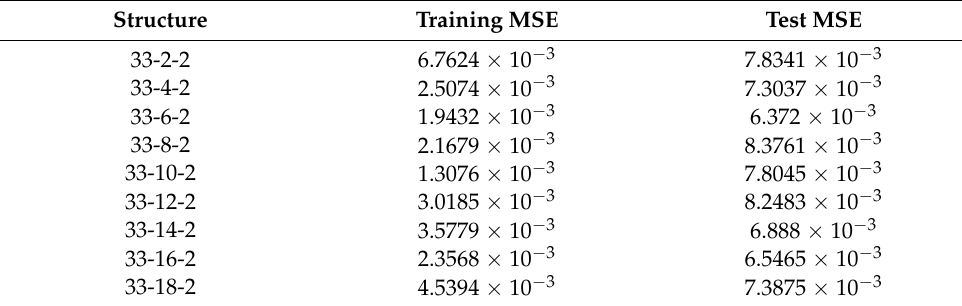
Table 2. Training and test results of different hidden